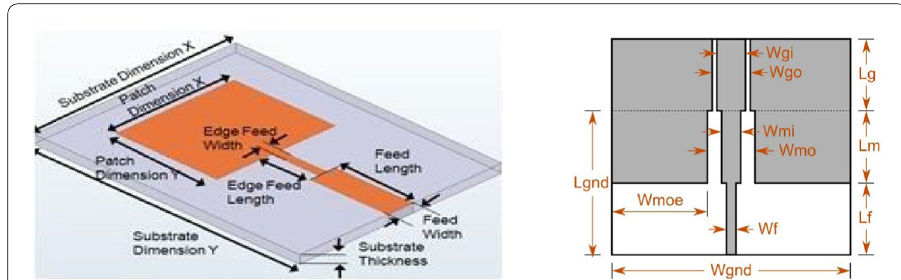
Fig. 7. 3D geometry for edge-fed microstrip patch